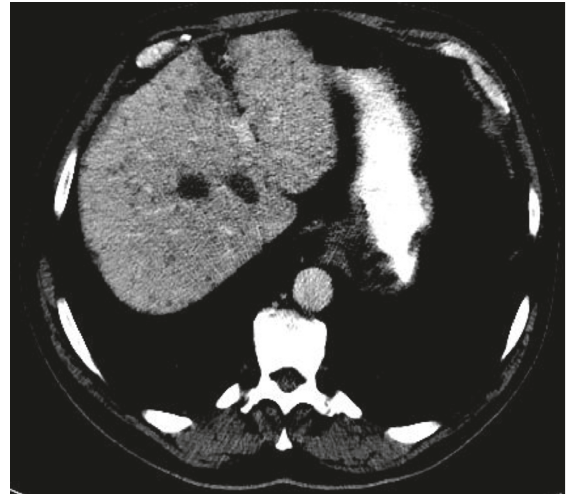
Figure 5: Surveillance CTabdomen/pelvis 3months after the initial one showing numerous new tiny hepatic lesions.